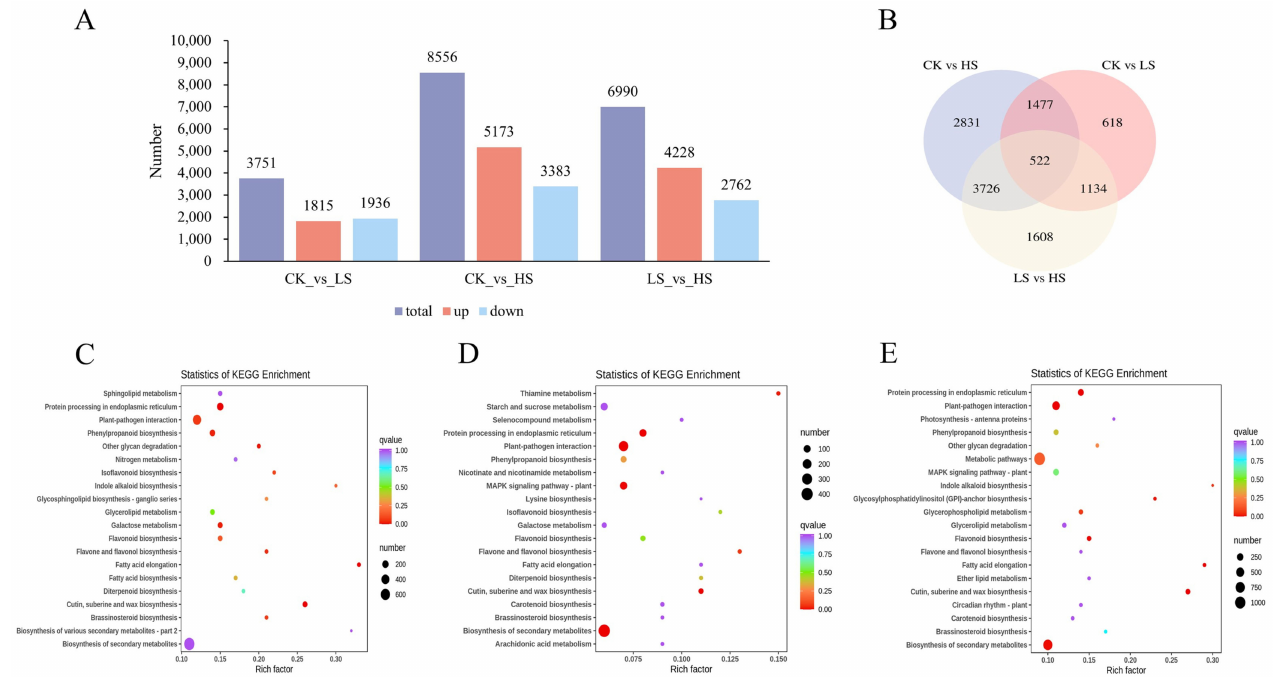
Figure 5. Identification and functional enrichment of differentially expressed genes of P. koraiensis under light stress. ( A ) The statistics of upregulated and downregulated DEGs in different comparison groups. ( B ) Venn diagram of DEGs in different comparison groups. ( C ) The top 20 KEGG enrichment pathways of DEGs in CK vs. HS. ( D ) The top 20 KEGG enrichment pathways of DEGs in CK vs. LS. ( E ) The top 20 KEGG enrichment pathways of DEGs in LS vs. HS. CK: control. LS: light shade. HS: heavy